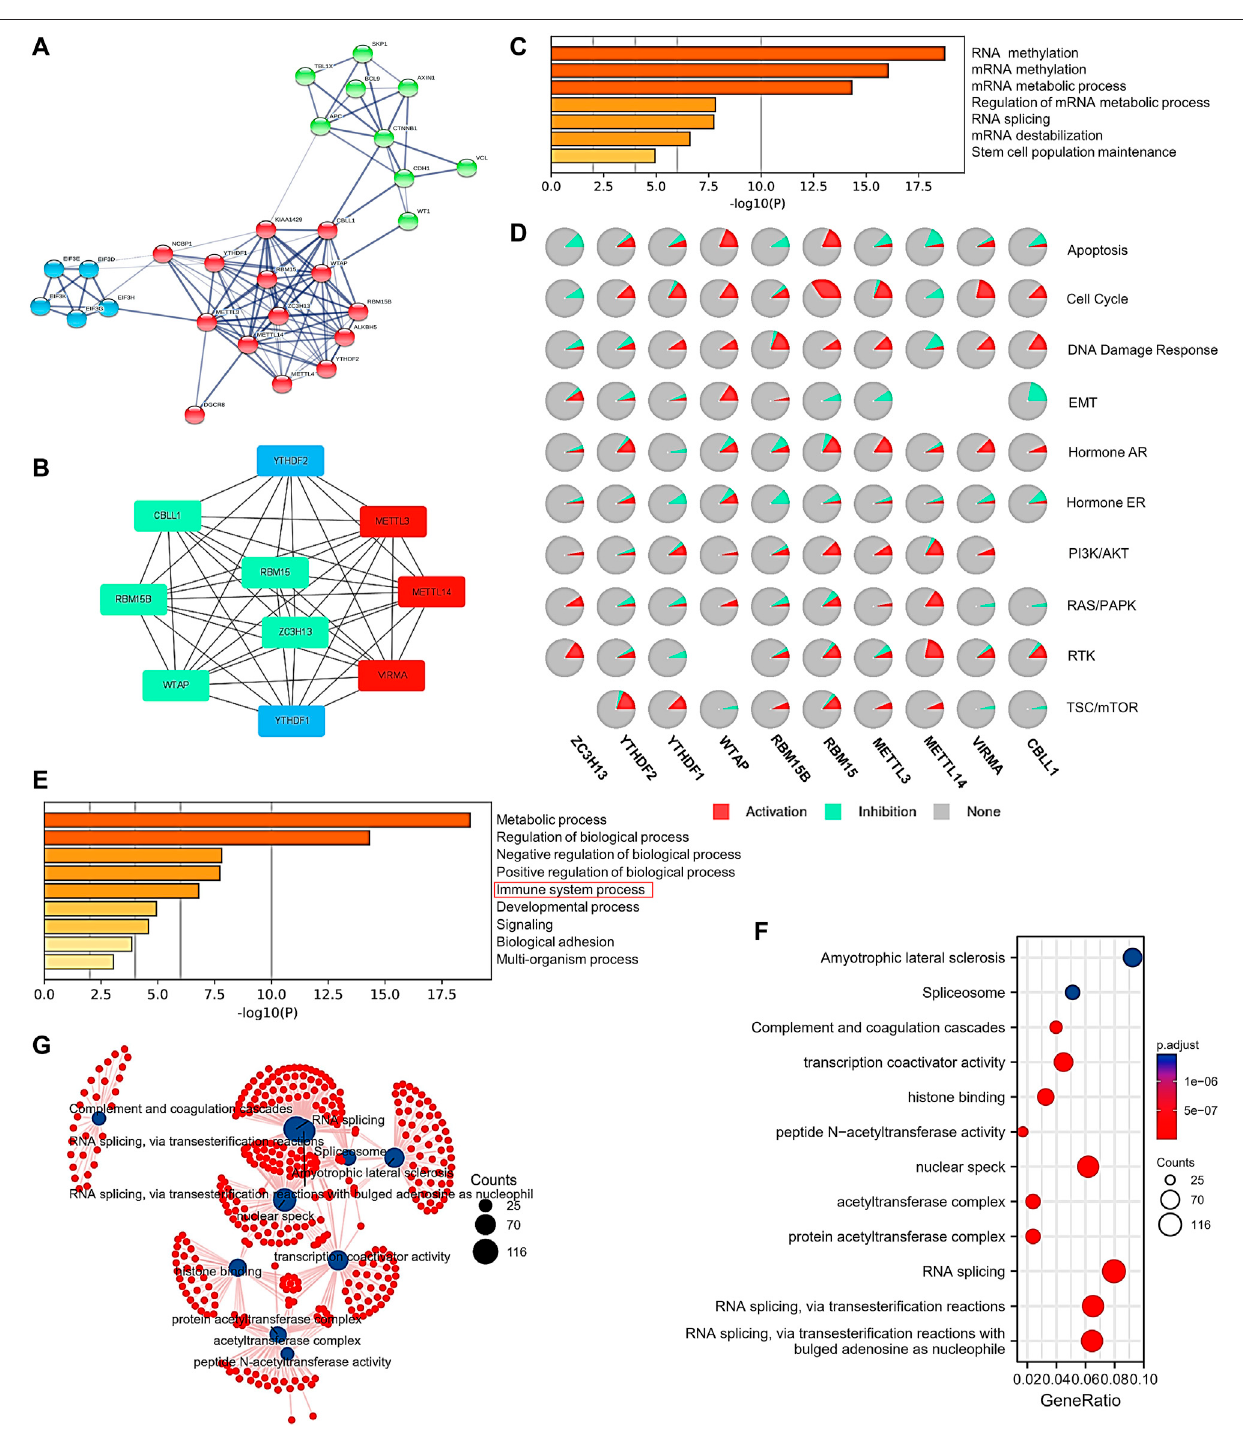
Frontiers in Cell and Developmental Biology |